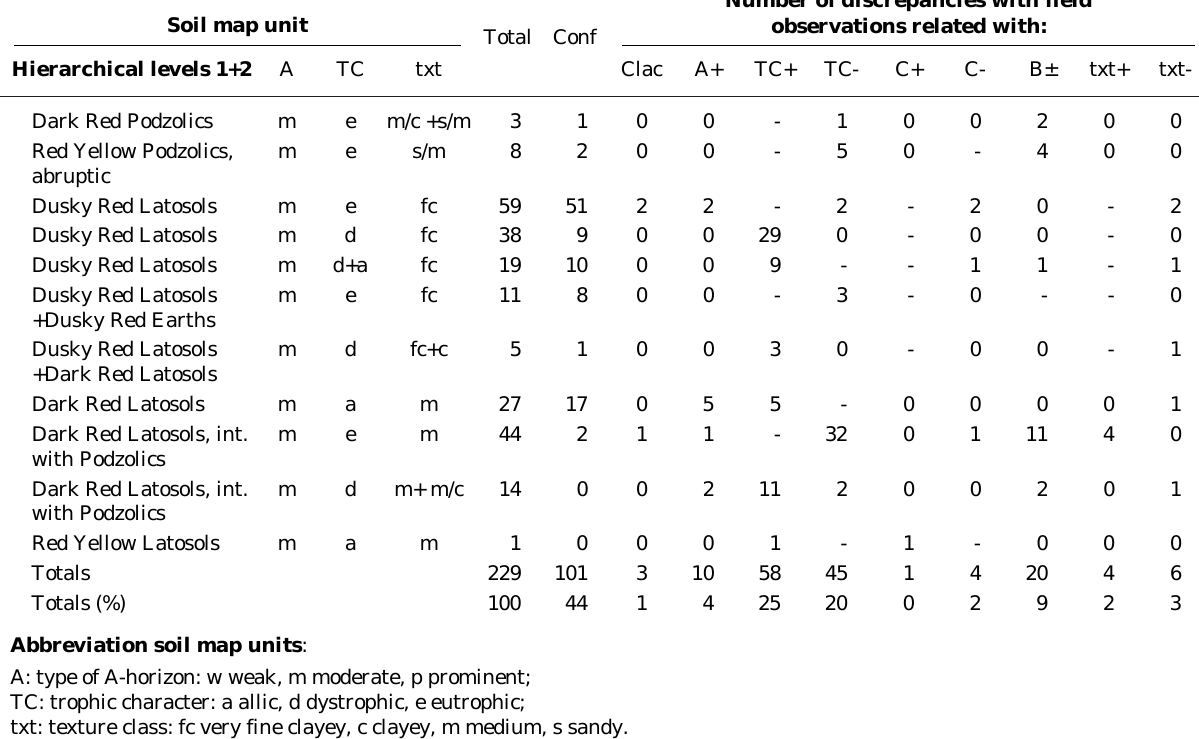
Table 3. Purity analysis for